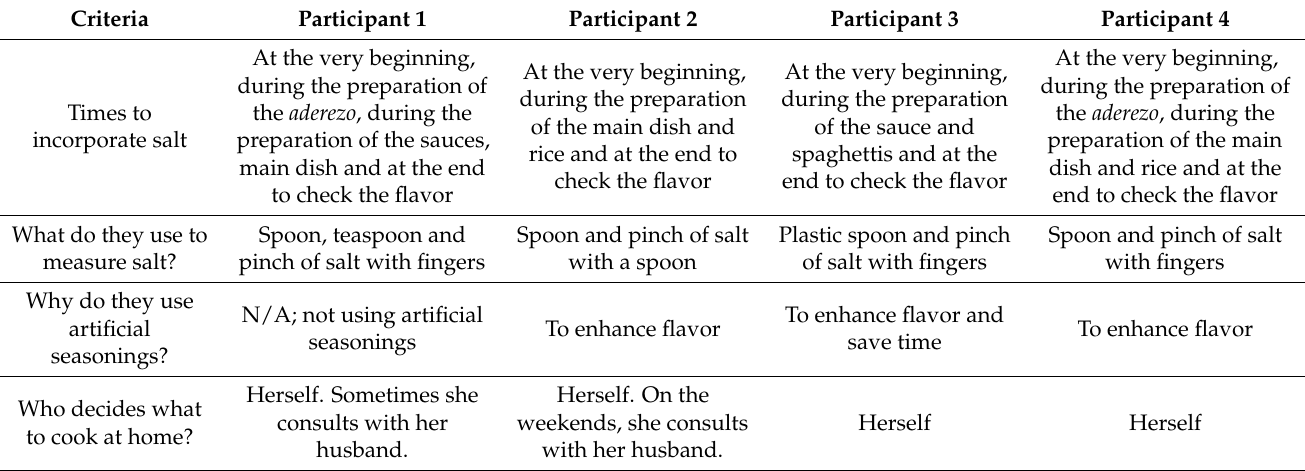
Table 1. Participants’ cooking practices and experiences around salt and artificial